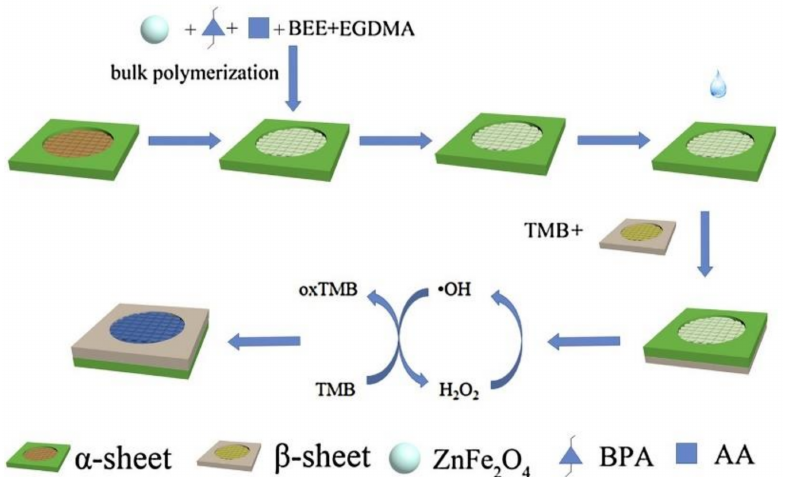
Figure 6. Construction of a paper-based MIP assay for the detection of BPA in liquid. Figure reproduced from [126] with permission from copyright Elsevier 2017.